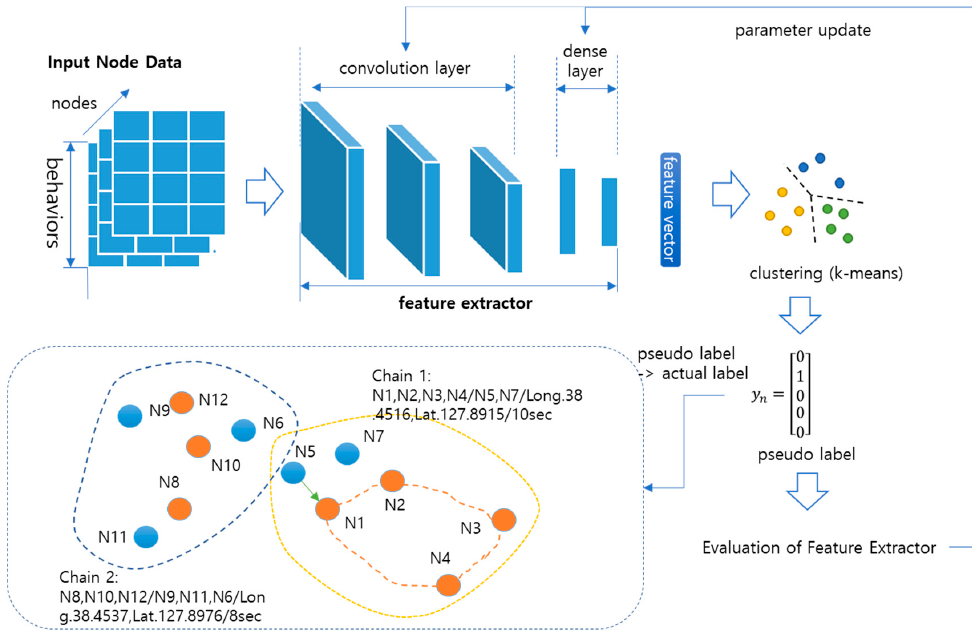
Figure 3. Deep clustering for dynamic IoT blockchain network.